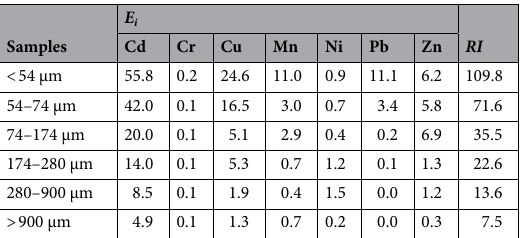
Table 6. Comparison of E i and RI values for heavy metals in fly ash samples.